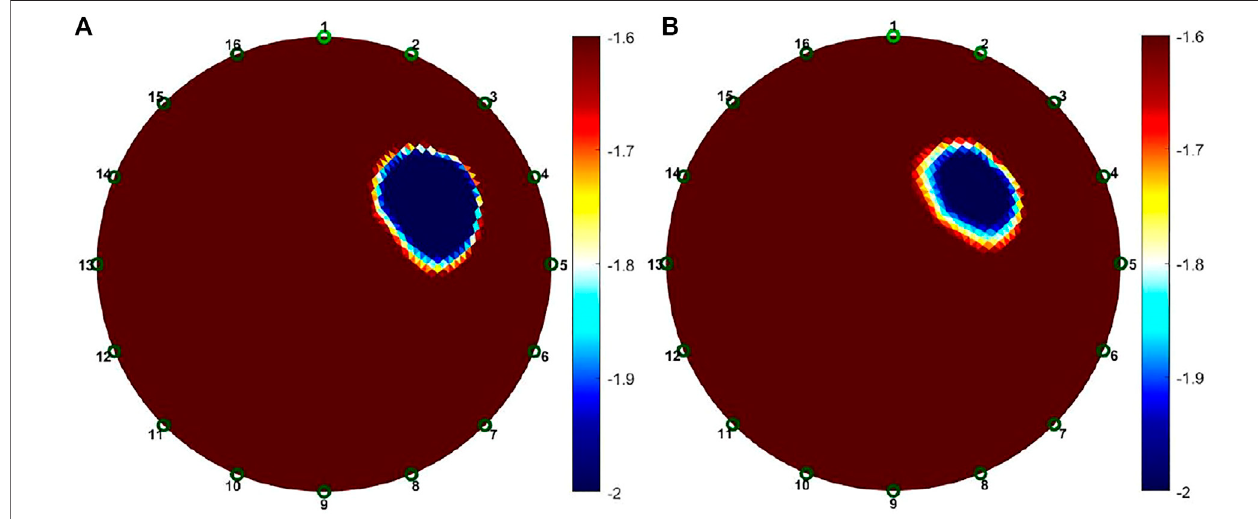
FIGURE 9 | Reconstruction of the saline- fi lled phantom using data obtained by (A) AM (hand selection) and (B) AX (multiplexed corrected using the fi rst method). QF = 83.